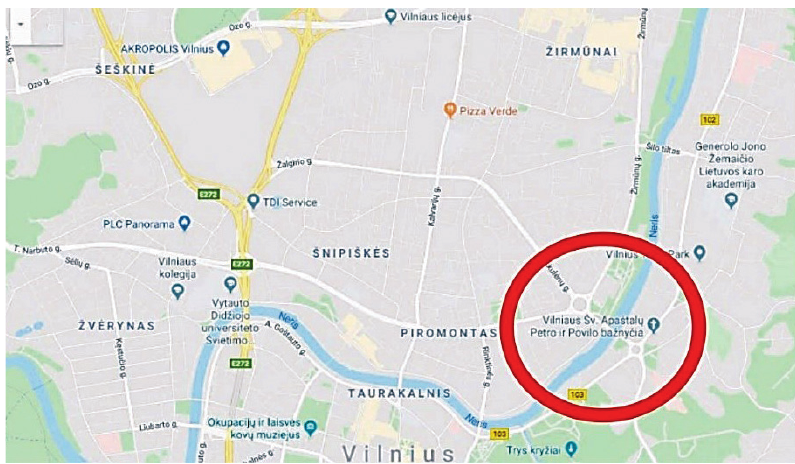
Figure 1. The geographical location of